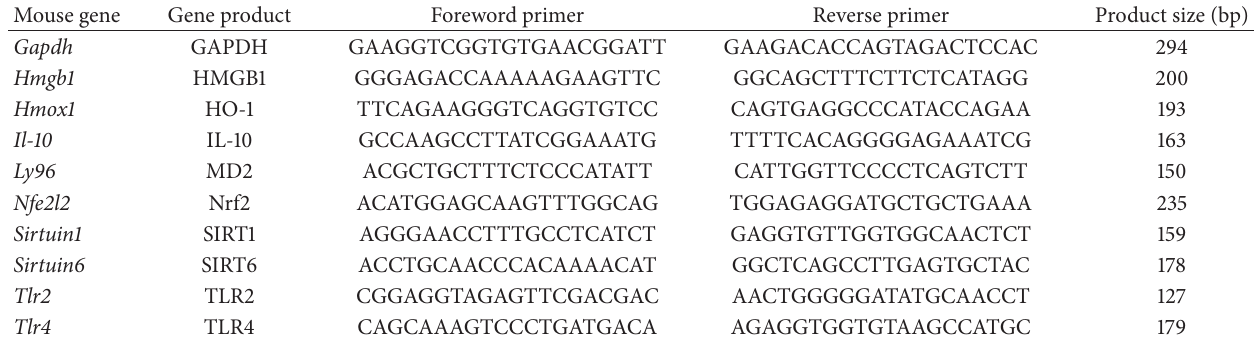
Table 1: Primer sequences for quantitative real-time PCR and the length of each PCR